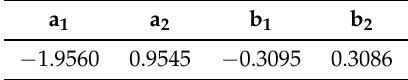
Table 3. The identified parameters of the autoregressive with exogenous inputs (ARX)